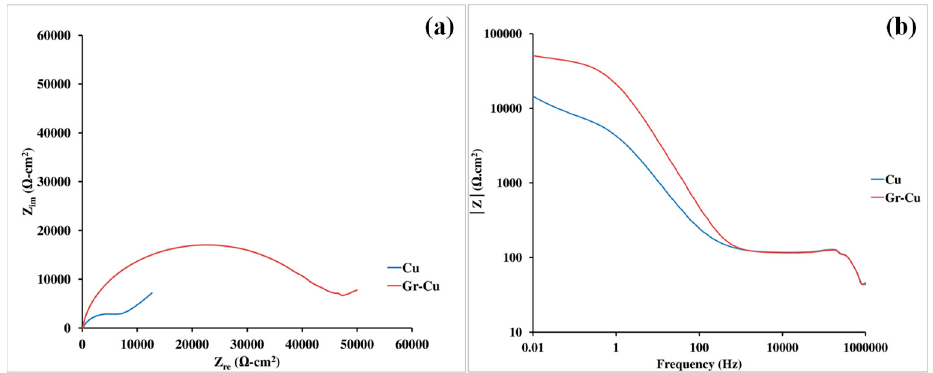
Figure 3. Corrosion resistance of bare copper (Cu), and graphene coated copper (Gr-Cu) in 0.1 M NaCl: ( a ) Nyquist plots (bare copper data reprinted with permission from [38], R. K. Singh Raman, A. Tiwari, JOM, 66, (4), 637-642 (2014). Copyright 2014 Springer) and ( b ) Bode modulus plots (bare copper data reprinted with permission from [39], A. Tiwari, R. K. Singh Raman, Corrosion & Prevention 2013 Conference, Brisbane, Australia, 2013; pp 1-7. Copyright 2013 Australasian Corrosion Association Inc.).